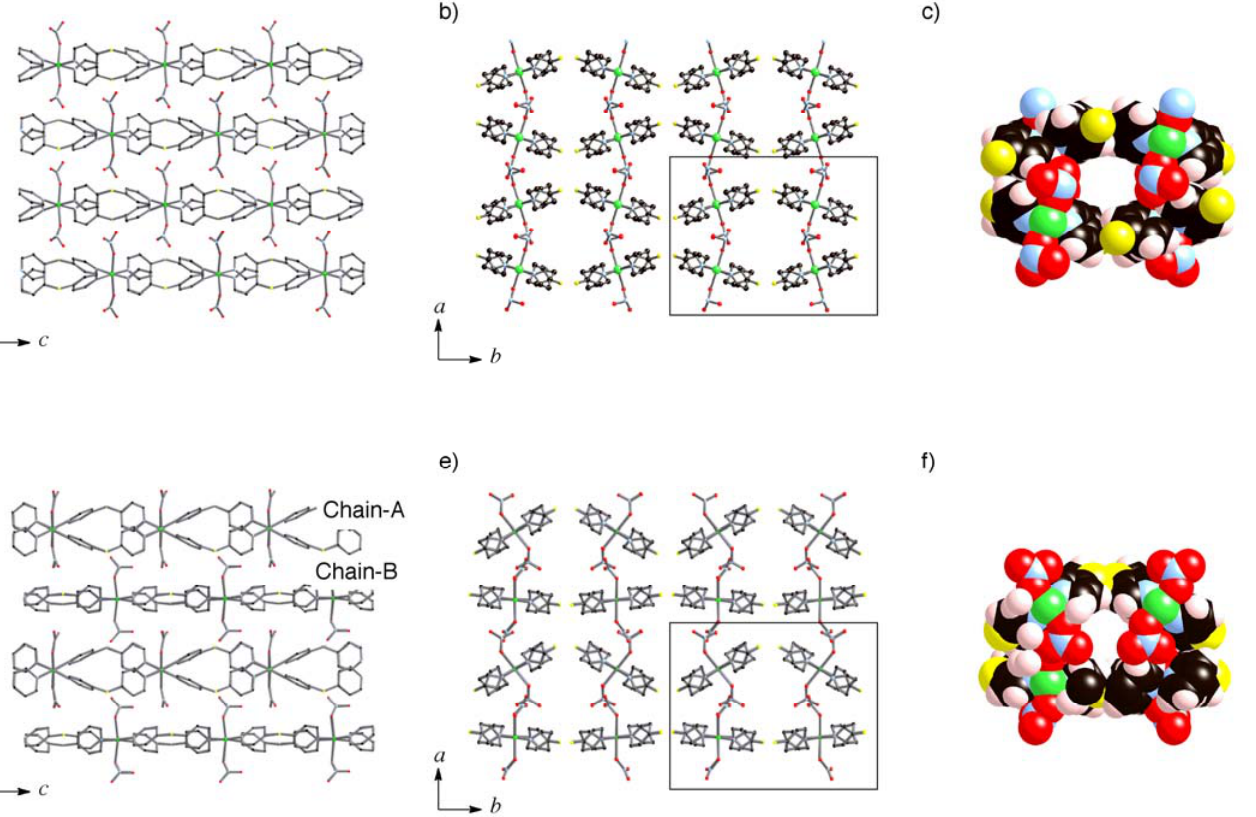
Figure 2. Crystal structures of 1  ( a - c ) and 1  ( d - f ). Ethanol molecules in the channels of ) chains along the b axis ( a , c , d , 1  are omitted for clarity. Stacking structures of ( Ni - dps 2 f ) and c axis ( b , e ) are exhibited. The channel formed by surrounding four chains is indicated by the rectangles in ( b ) and ( e ). Their channel structures with van der Waals radii are revealed in ( c ) and ( f ). Except for ( c ) and ( f ), the hydrogen atoms are omitted for